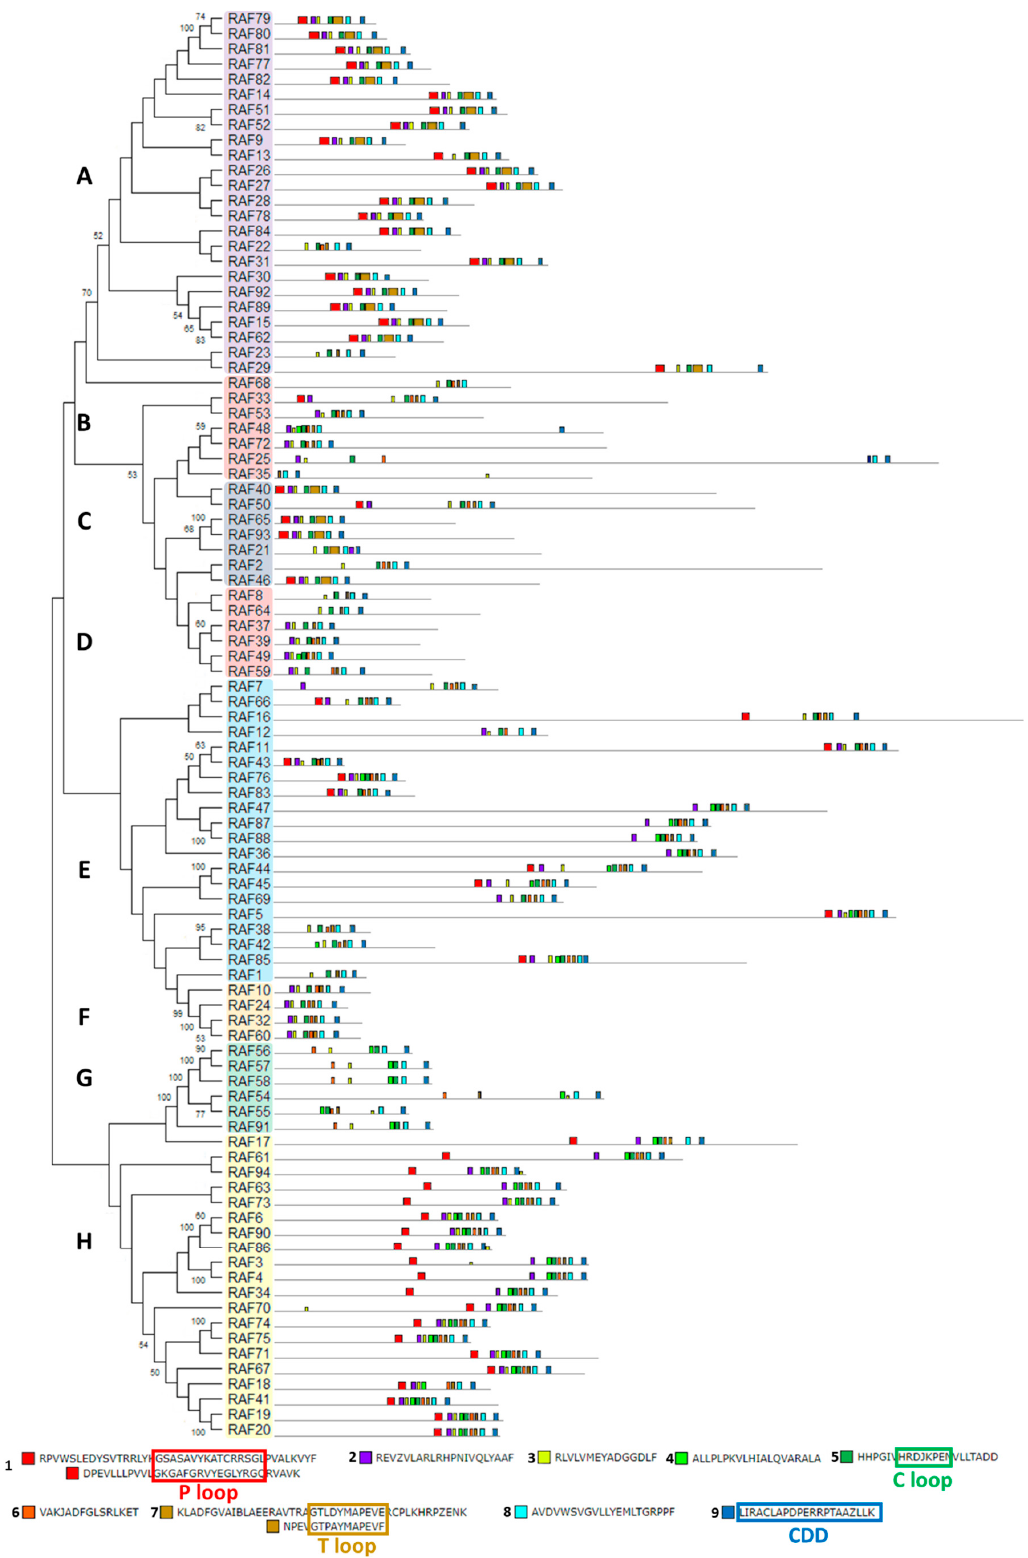
Figure 9. Phylogenetic and motif analysis of RAF-type MAPKKKs. The RAF-type MAPKKKs classified by phylogenetic analysis is shown on the left. Each phylogenetic group has a different background color. On the right, the analysis of their domains identified with the MEME program. Below, the conserved sequence of the identified domains. For other details see Figure 2.